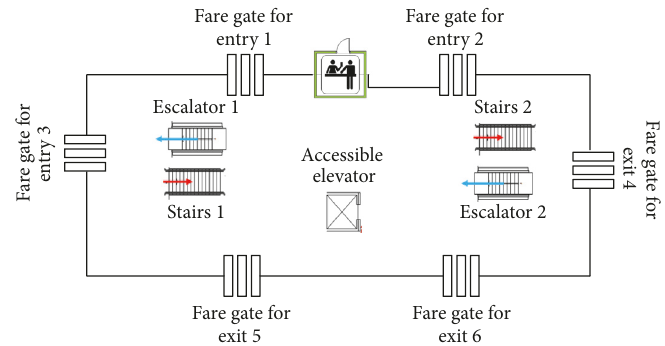
Figure 3: The layout of the station hall in QiBao